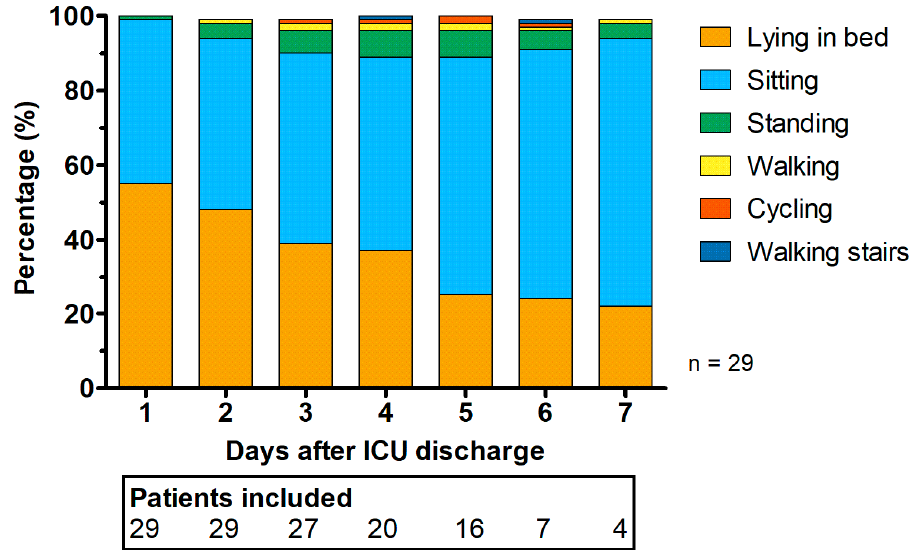
Figure 2. Relative time spent per activity per postoperative day at the cardio-thoracic surgery ward between 7 a.m. and 11 p.m. A decrease in lying in bed (orange) and an increase in sitting (sky blue) were observed during the hospital stays. The number of included patients decreased because of the varying length of stay and discharge from the